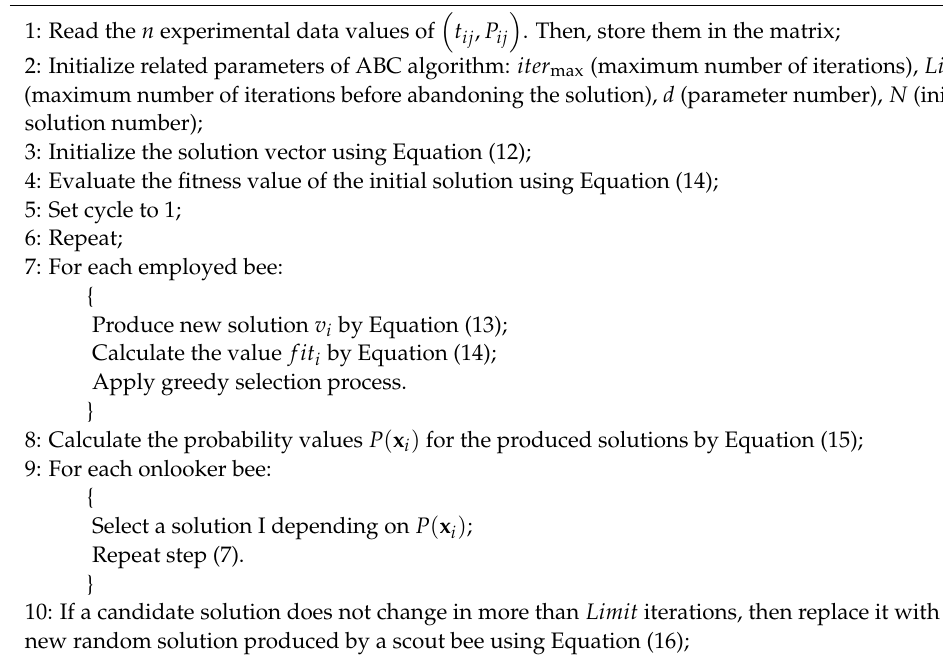
Algorithm A1. Identifying acceleration factors using an artificial bee colony